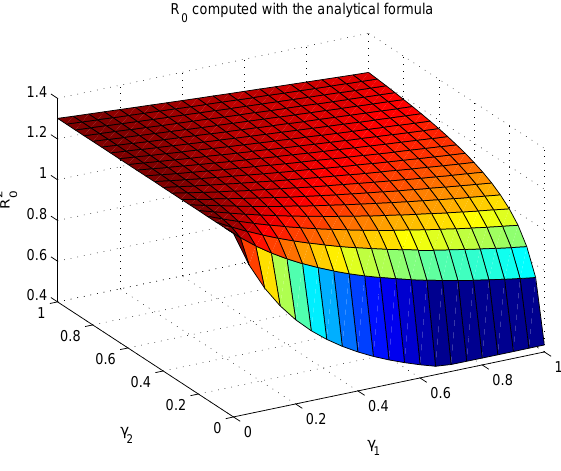
Fig. 6. Evolution of R 2 0 with respect to γ 1 and γ